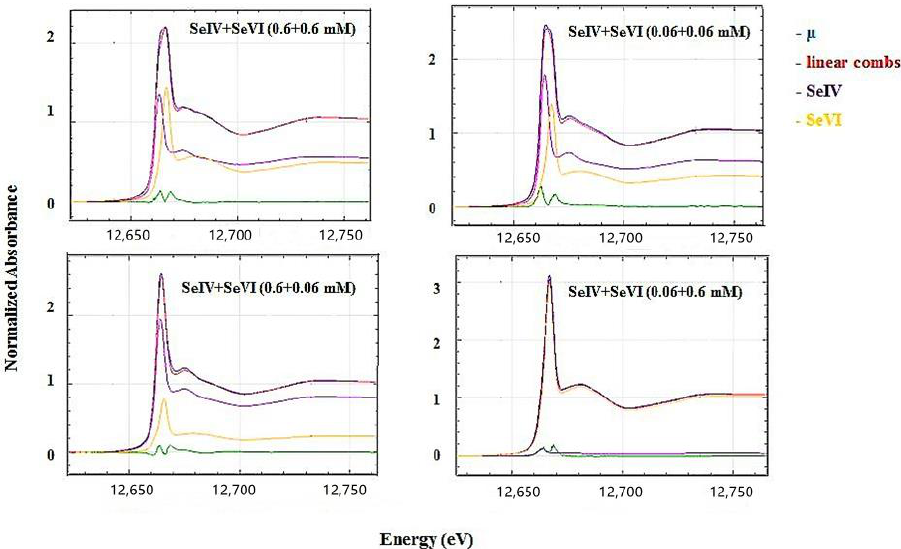
Figure 6. Se K-edge XANES results for Se(IV) and Se(VI) at different mixture ratios adsorbed onto SorbS (1 g/L) after 48 h at pH 3.